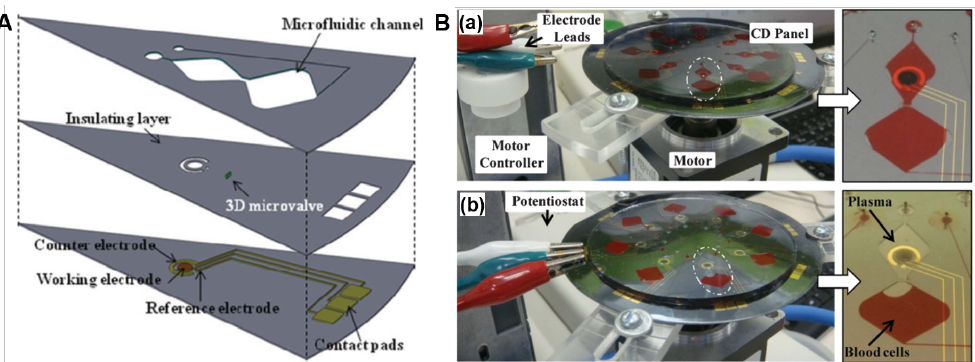
Figure 13. ( A ) Conceptual design of one of eight testing sites displaying each consecutive layer of the PDMS electrochemical-LoaD: a microfluidic layer, an insulating layer and a biosensing layer. ( B ) Electrochemical-LoaD whole blood analysis: ( a ) sample loaded ready for rotation, and ( b ) sample centrifuged and the plasma isolated for measurement of electrochemical signal. Reproduced from [180] with permission from The Royal Society of